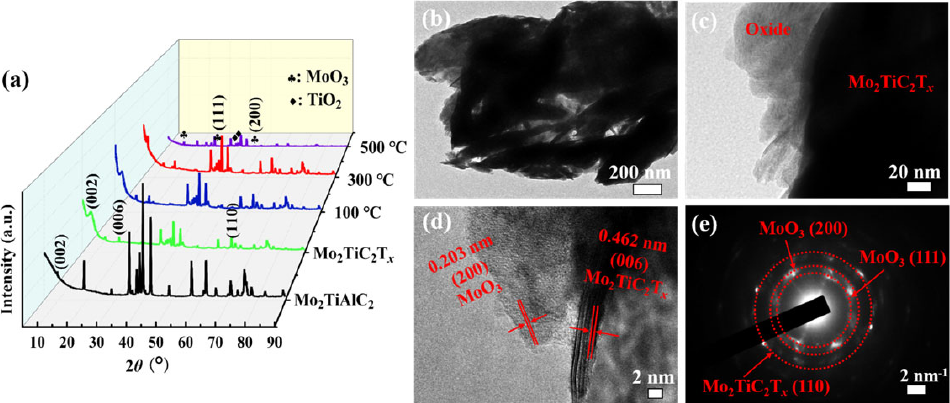
Fig. 3 (a) XRD patterns, (b, c) TEM images, (d) HRTEM image, and (e) SAED pattern of MoO 3 /TiO 2 /Mo 2 TiC 2 T x composit annealing treated at 300 .